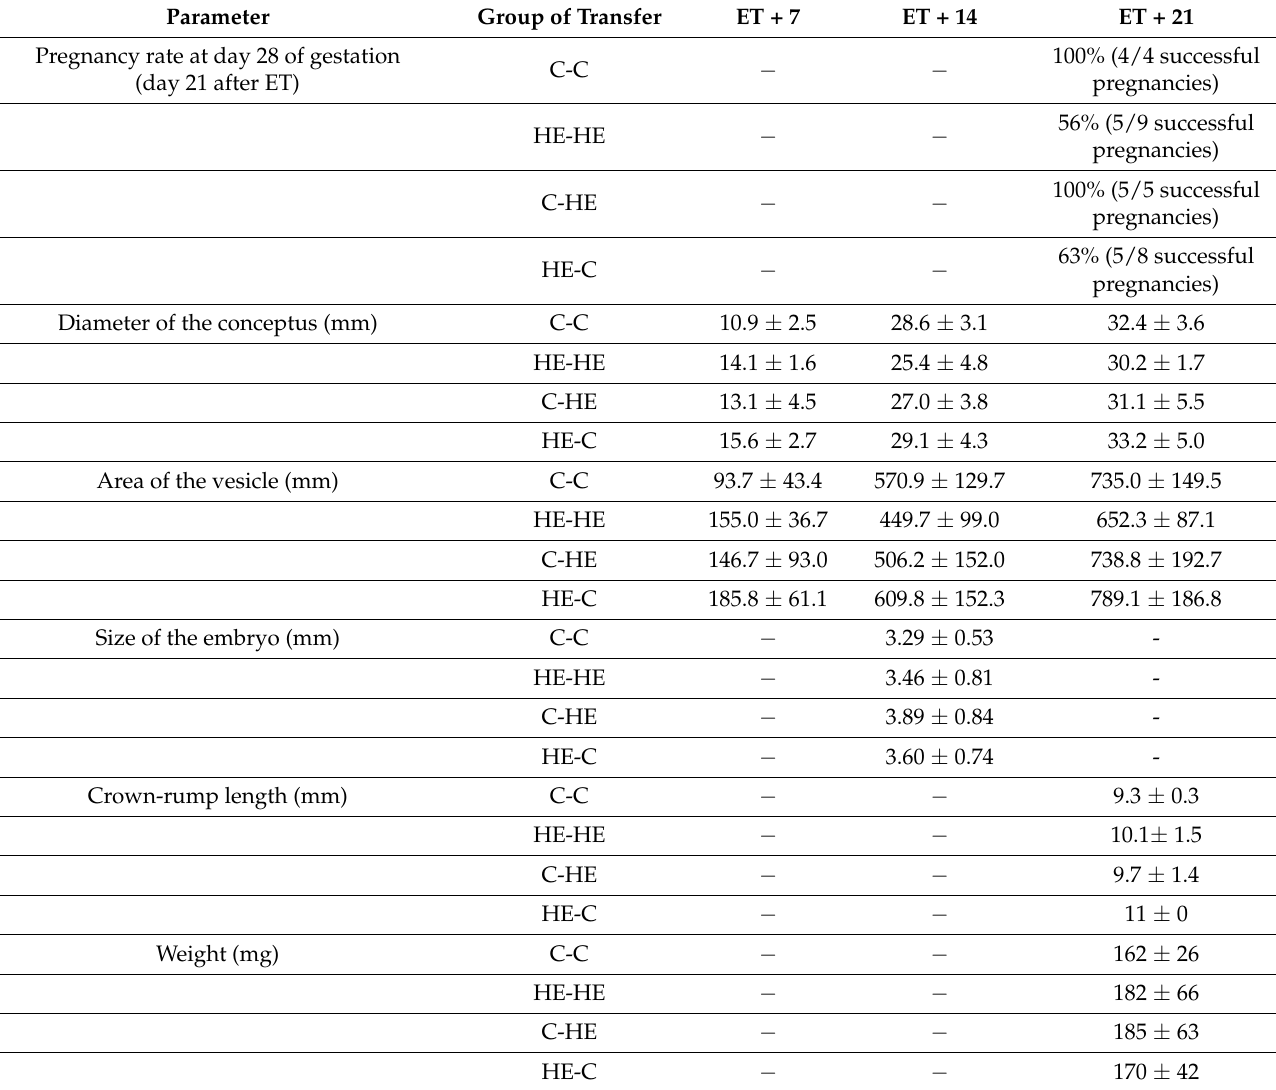
Table 3. The pregnancy rate at day 28 of gestation (21 days after embryo transfer). Mean ± SD diameter of the conceptus and area of the embryonic vesicle at 7 (ET + 7), 14 (ET + 14), and 21 (ET + 21) days after embryo transfer (ET), size of the embryo at ET + 14 and crown-rump length and weight of the embryo at ET + 21, presented per embryo transfer group (control to control mare (C-C), control to high-energy mare (C-HE), high-energy to control mare (HE-C), and high-energy to high-energy mare